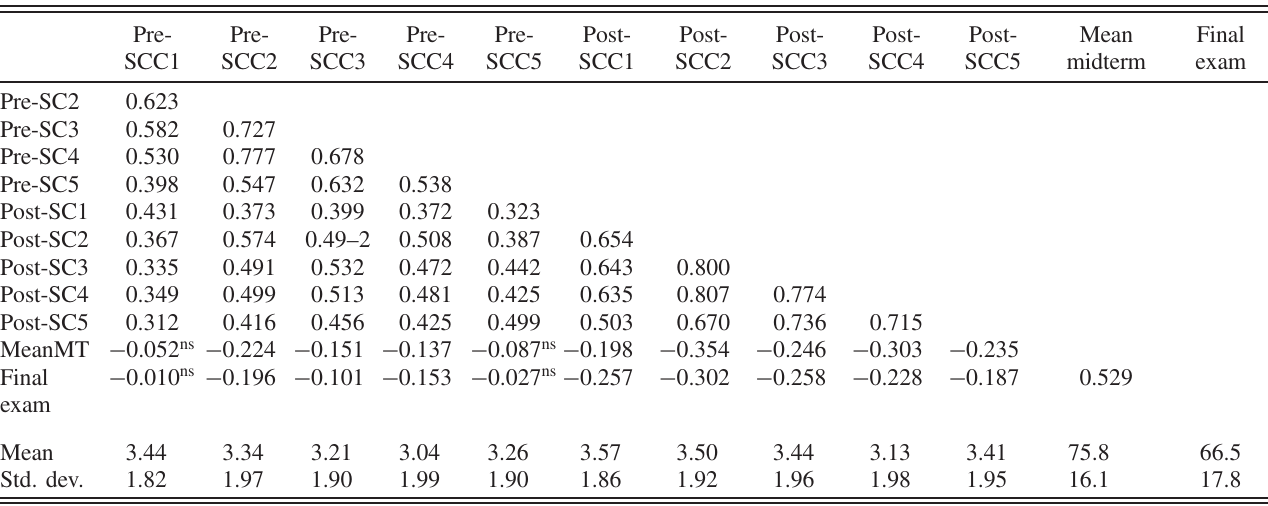
TABLE VI. Correlations and summary statistics of variables in SEM. All values are significant at p < 0 . 05 , except for the cells marked “ ns ”